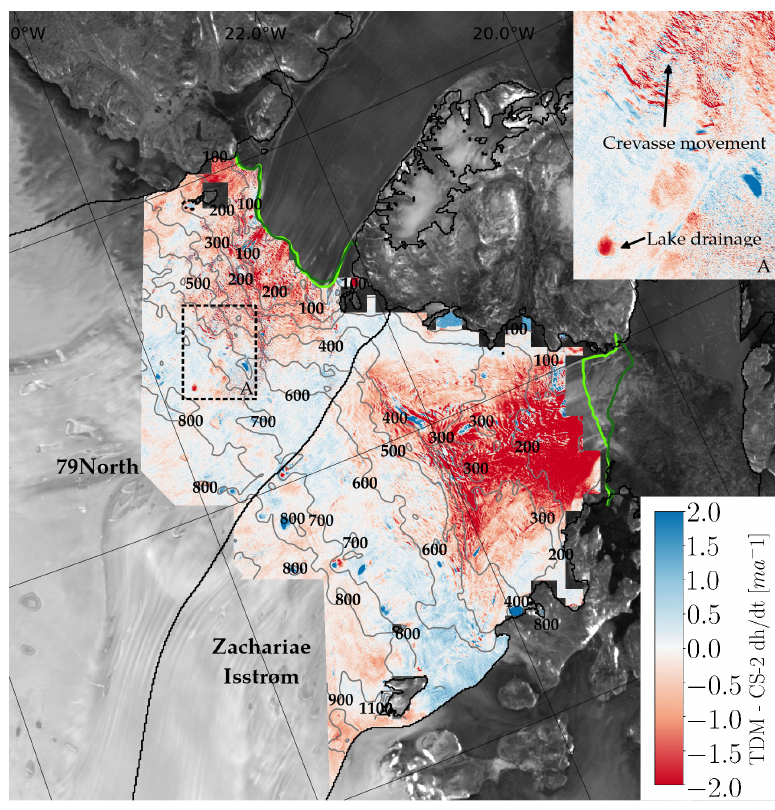
Figure 4. Difference of the TDM SECR map and the CS-2 SECR (TDM—CS-2) for the termini of Zachariæ Isstrøm and 79North where measurements from both sensors overlap. Contour lines for absolute elevation are shown for the interpretation of Figure 5a. Calving fronts (green lines) and basin delineation (black line) are in Figure 1. Inset A shows differences in elevation change because of lake drainage and crevasse movement that is only captured in the high resolution TDM